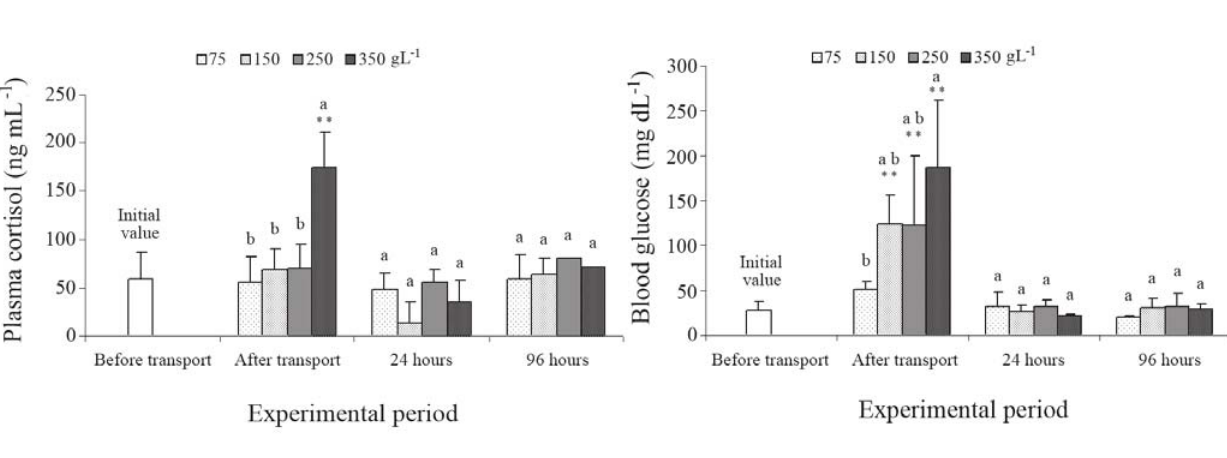
Fig. 1. Plasma cortisol and blood glucose of jundiá juveniles transported at different loading densities. Different letters over the bars indicate significant differences (P < 0.05) among treatments within each experimental time. Asterisks show significant differences (P < 0.001) when compared to the initial